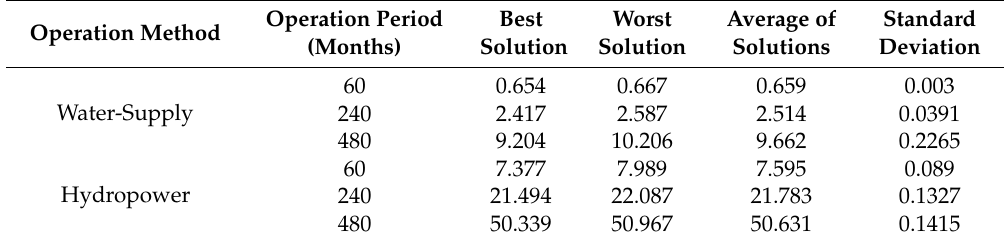
Table 5. Results of “Dez” reservoir operation using CSS algorithm over 5—Disregarding evaporation